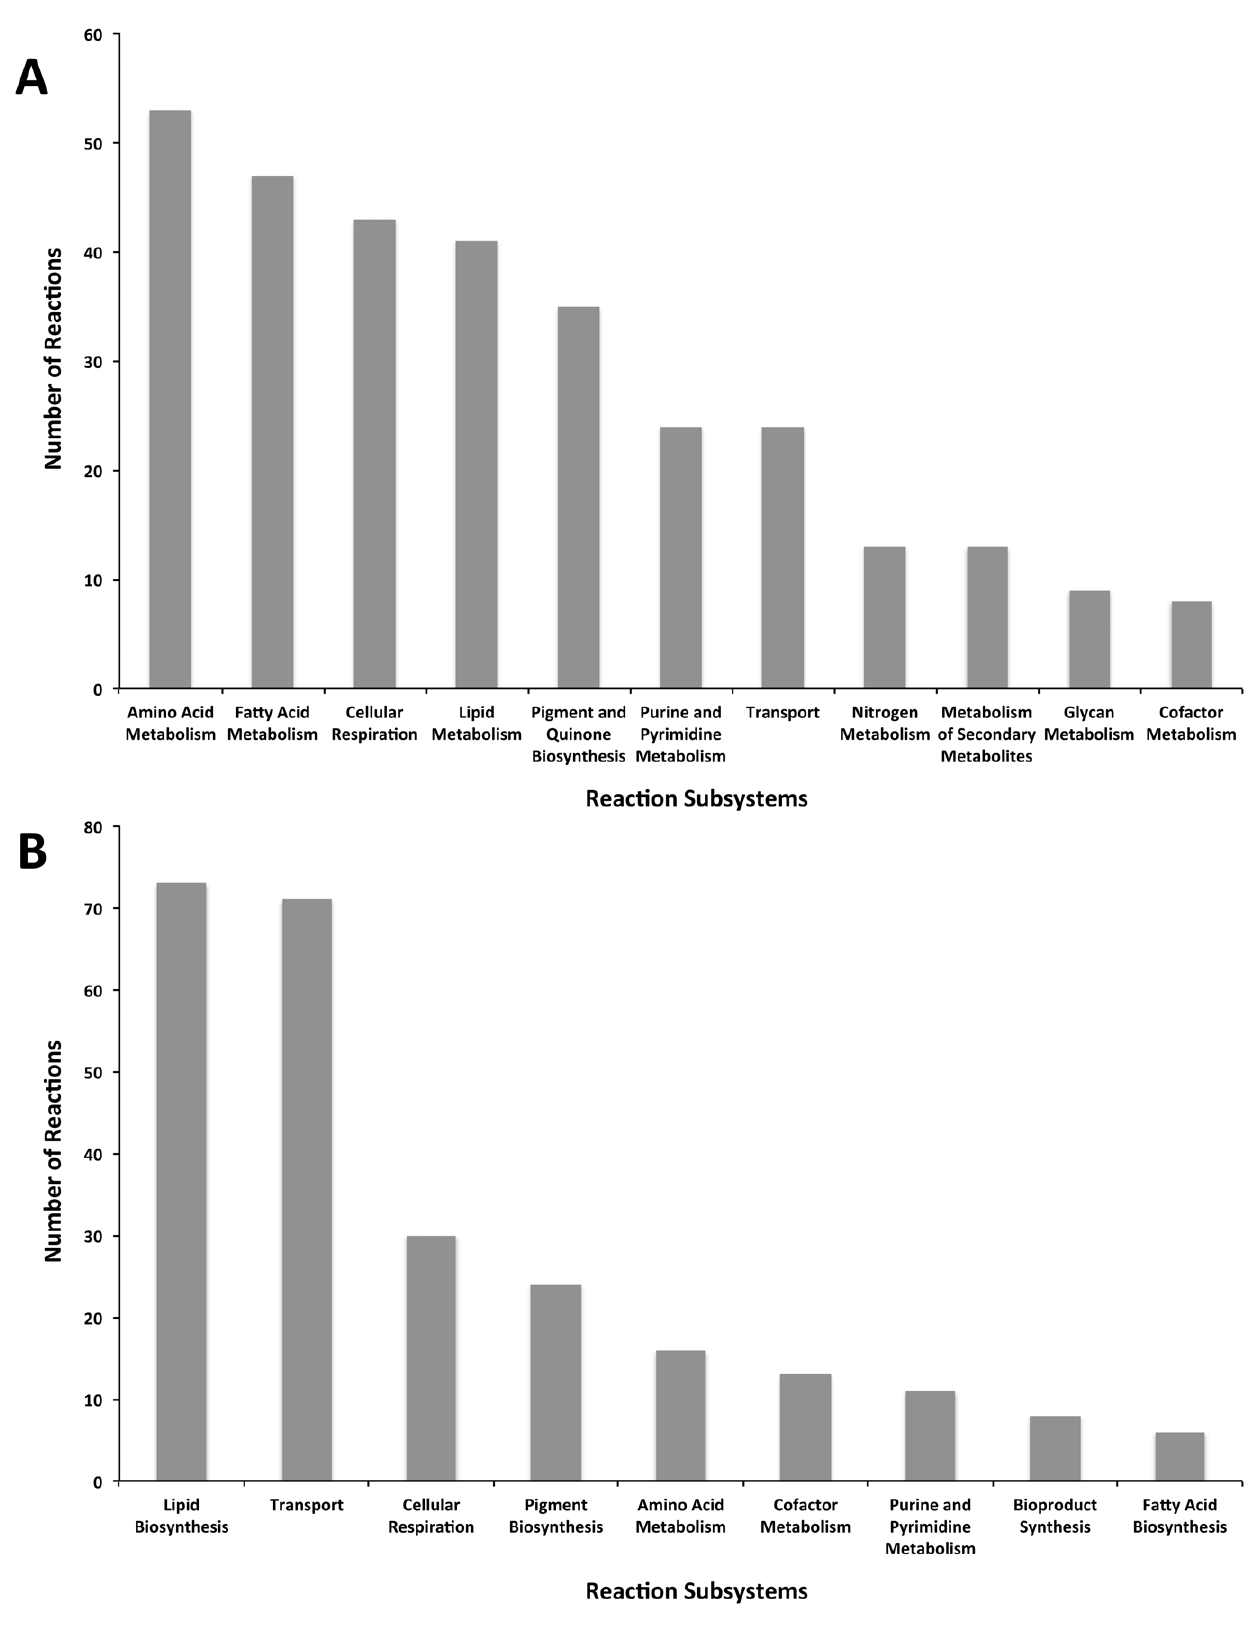
Figure 5. List of added reactions across pathways. (A) i Syn731 compared to i JN678 [32], and (B) i Cyt773 compared to i Cce806 [25].